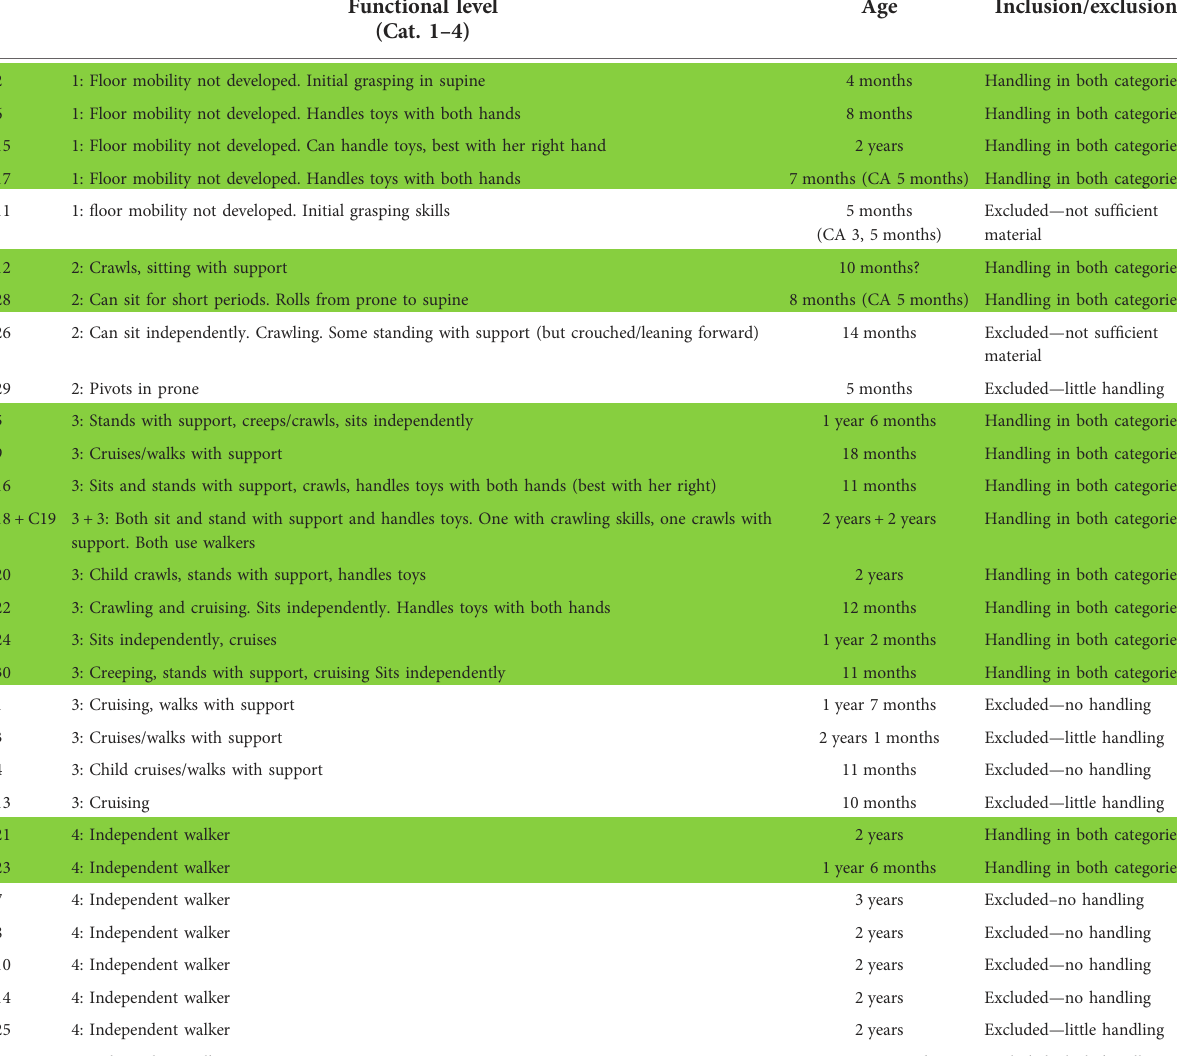
TABLE 1 Overview of the participating children ’ s functional level and age, and the inclusion/exclusion